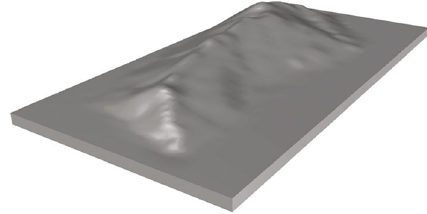
Figure 6: 3D calculation model